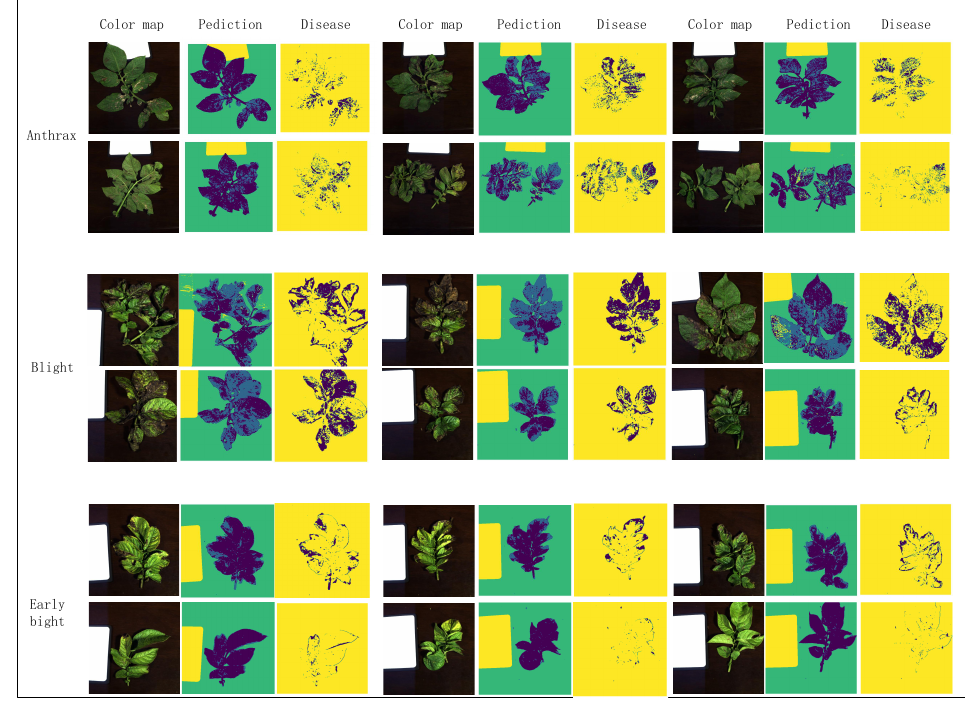
Figure 12. Disease detection through multidimensional fusion of